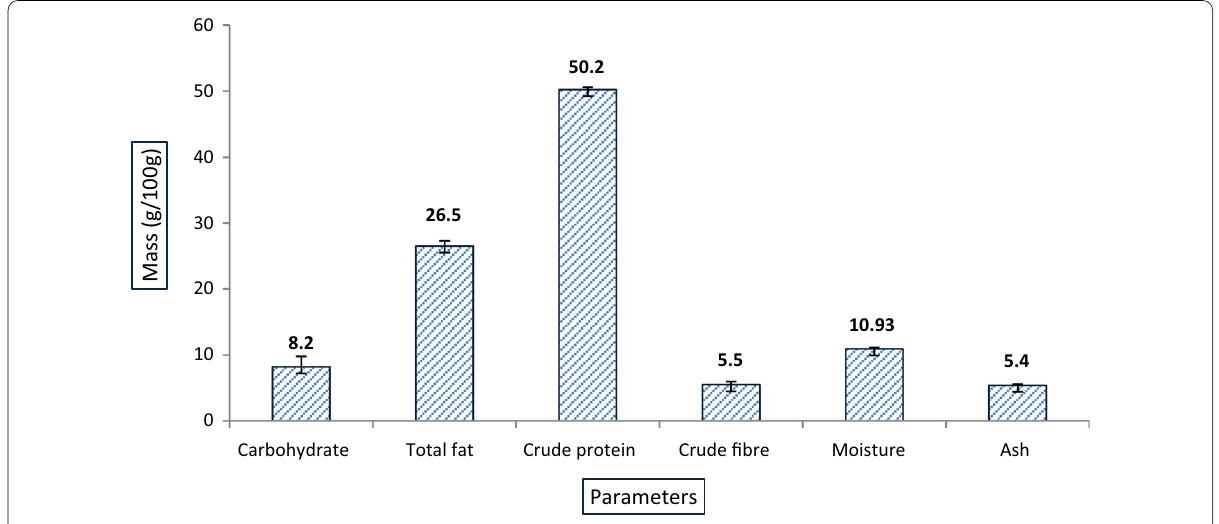
Fig. 1 Graph showing the proximate compositions of Coiblemmus